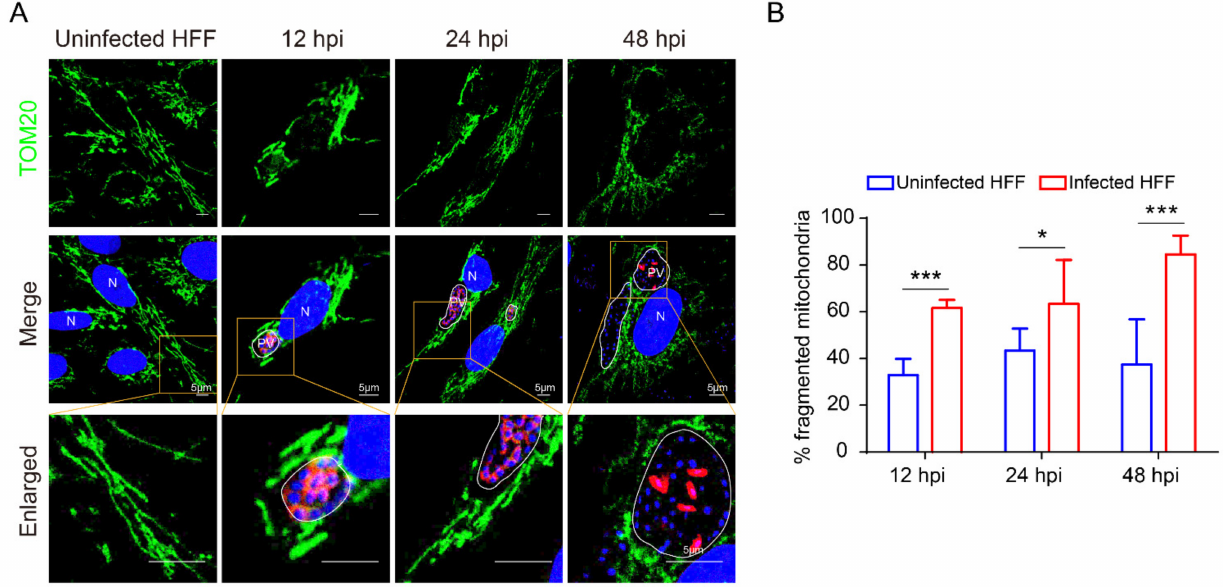
Figure 3. Analysis of the HMF in early and late stages of infection. ( A ) Observation of the mito- chondrial morphology in E. hellem -infected HFF cells at 12, 24, and 48 hpi. Laser confocal shows nucleus labeled with Hoechst (blue), mitochondria labeled with anti-TOM20 antibody (green), and E. hellem meront labeled with FISH probe (red). The yellow box shows an enlarged view. Bar, 5 µ m. PV, parasitophorous vacuole; N, nucleus. ( B ) Comparison of the HMF percentage between infected and uninfected HFF cells. At least 10 cells for each separate experiment were counted. * p < 0.05; *** p <